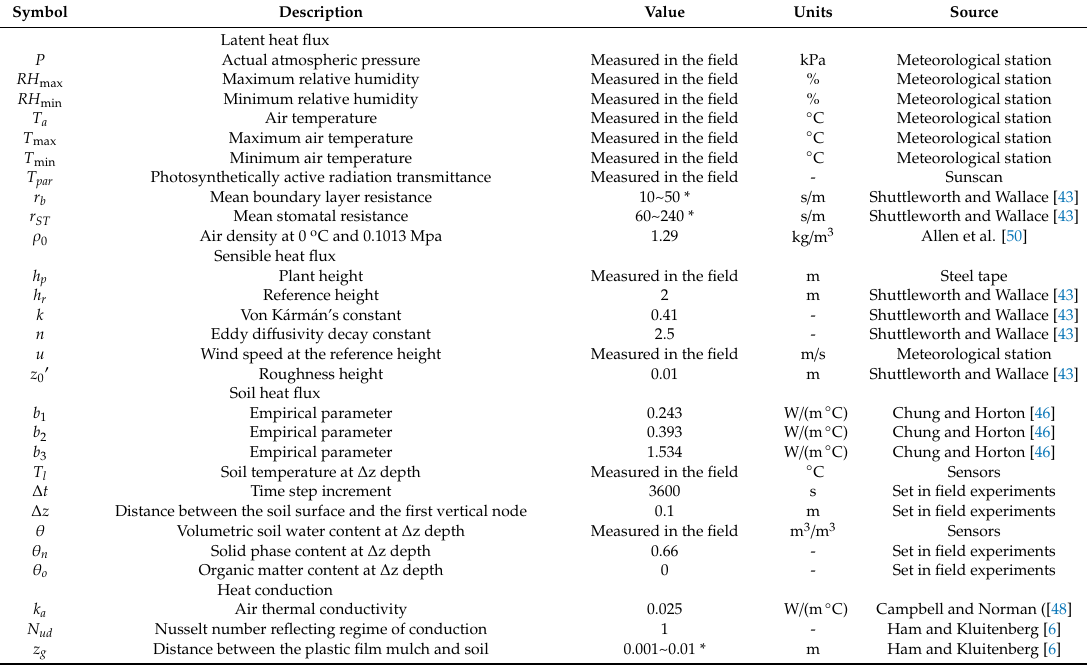
Table 2. Input parameters for the latent heat flux, sensible heat flux, soil heat flux, and heat conduction calculations using in modeling the interaction of plastic film mulch and potato canopy growth on soil heat